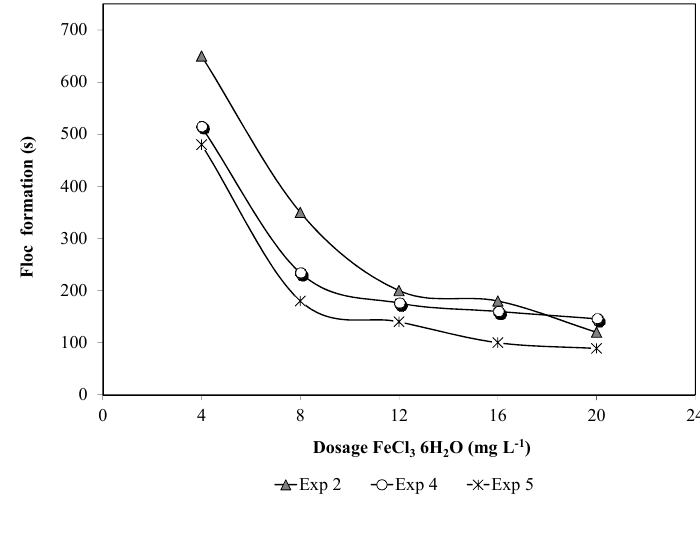
Figure 7. Influence of FeCl Exp 2, 4 and 5 ( n = 3).